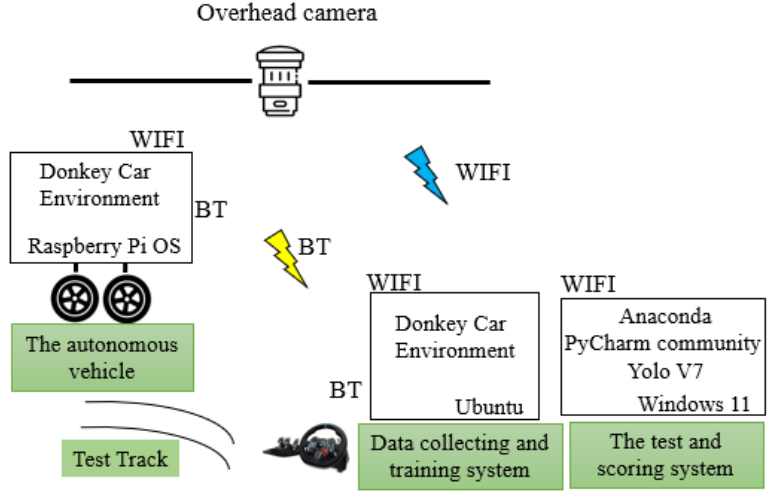
Figure 1. System block diagram.